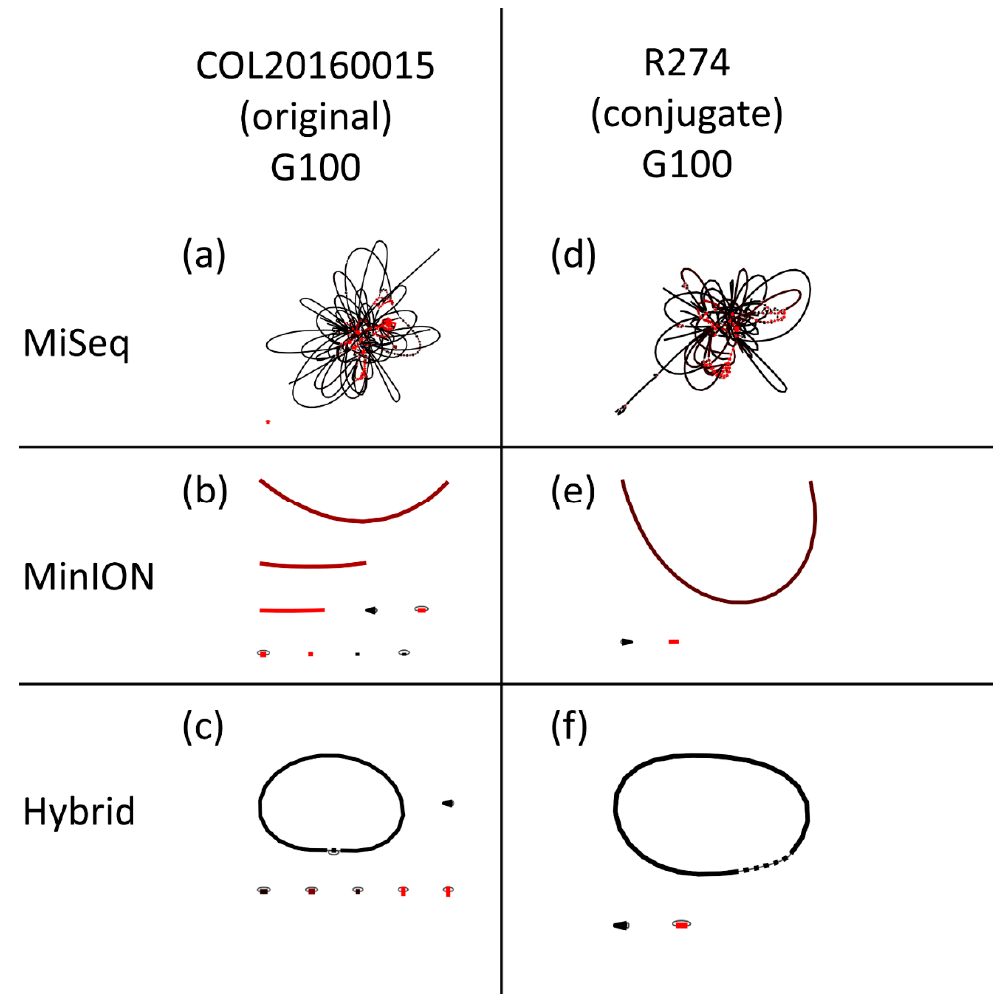
Figure 2. Visualizations of the assembly graphs with Bandage of the MiSeq, MinION and hybrid assemblies performed on the whole-genome DNA extractions (Genomic Tip 100) of the original E. coli COL20160015 ( a – c ) and the conjugate R274 ( d – f ). Each line represents a contig, and a red line represents a contig occurring in higher coverage compared to the other contigs within the same assembly. The thinner black lines are the most likely paths between contigs.